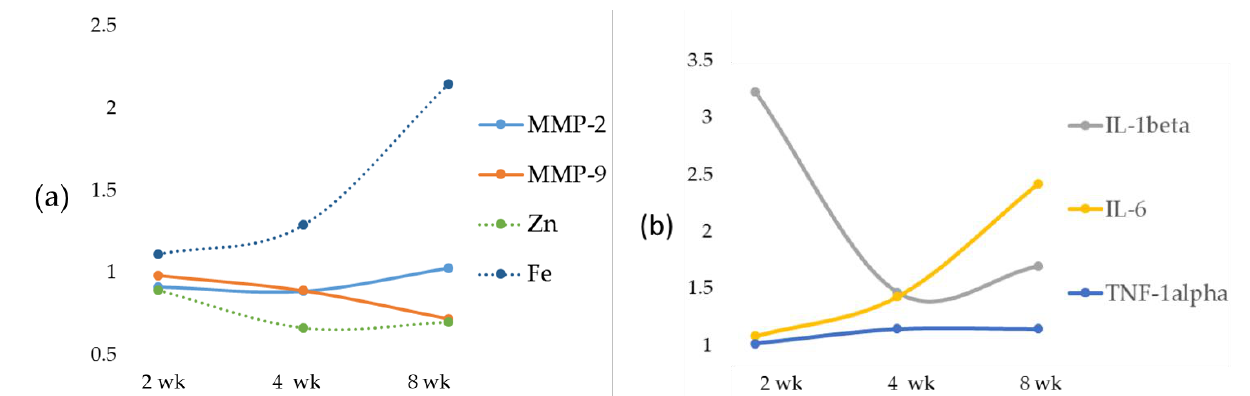
Figure 5. Time-dependent changes in serum Zn, Fe and MMPs ( a ) and in IL-1beta, IL-6 and TNF-alpha ( b ), expressed as a fold increase/decrease in their respective controls. Weeks (wk). In MCD rats, correlation analysis of serum Zn versus MMPs, IL-1beta, IL-6 and TNF- alpha showed an inverse correlation with IL-1beta and TNF-alpha (Table 6). No correlation was found for MMP-2, MMP-9 and IL-6. Table 6. Correlation between serum Zn and Fe versus MMPs, IL-1beta, IL-6 and TNF-alpha. Zn